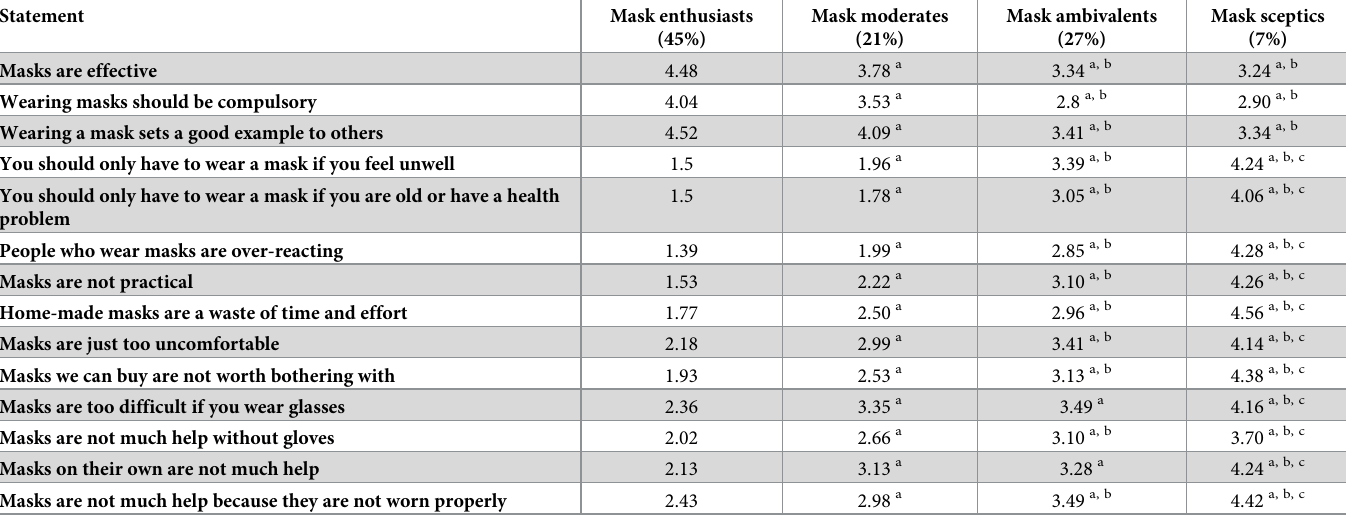
Table 7. Belief segments for wearing masks 1